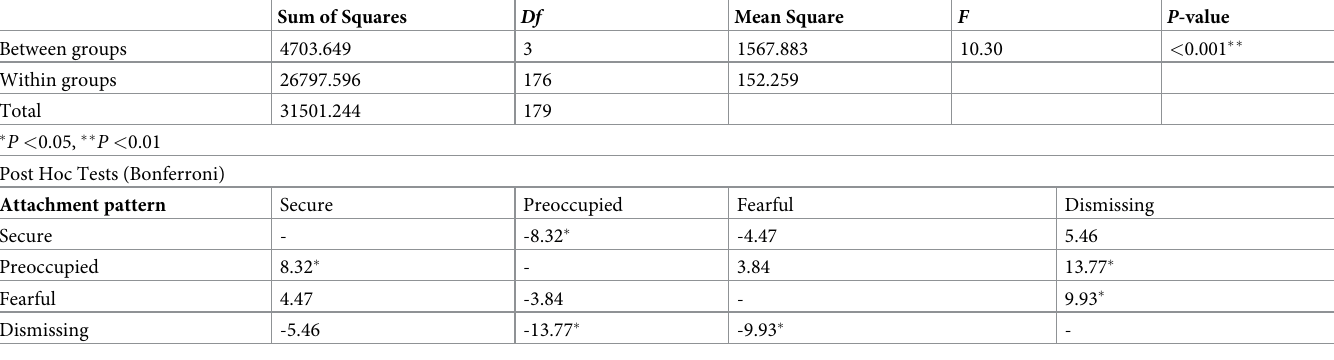
Table 3. Compared BDI-II score by one-way ANOVA. Sum of